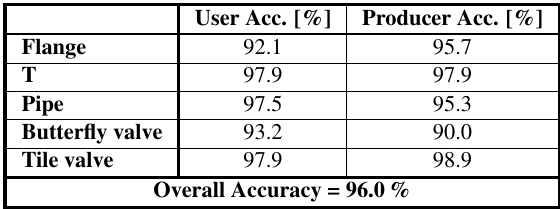
Table 2: User Accuracy and Producer Accuracy obtained on each class and Overall accuracy on 3D point cloud.